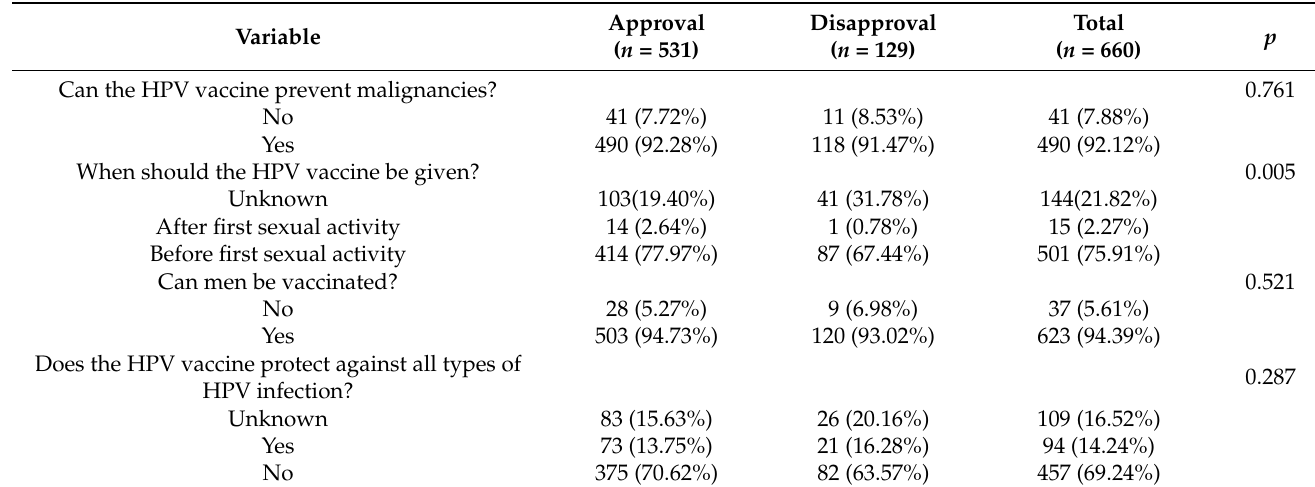
Table 4. Knowledge of HPV